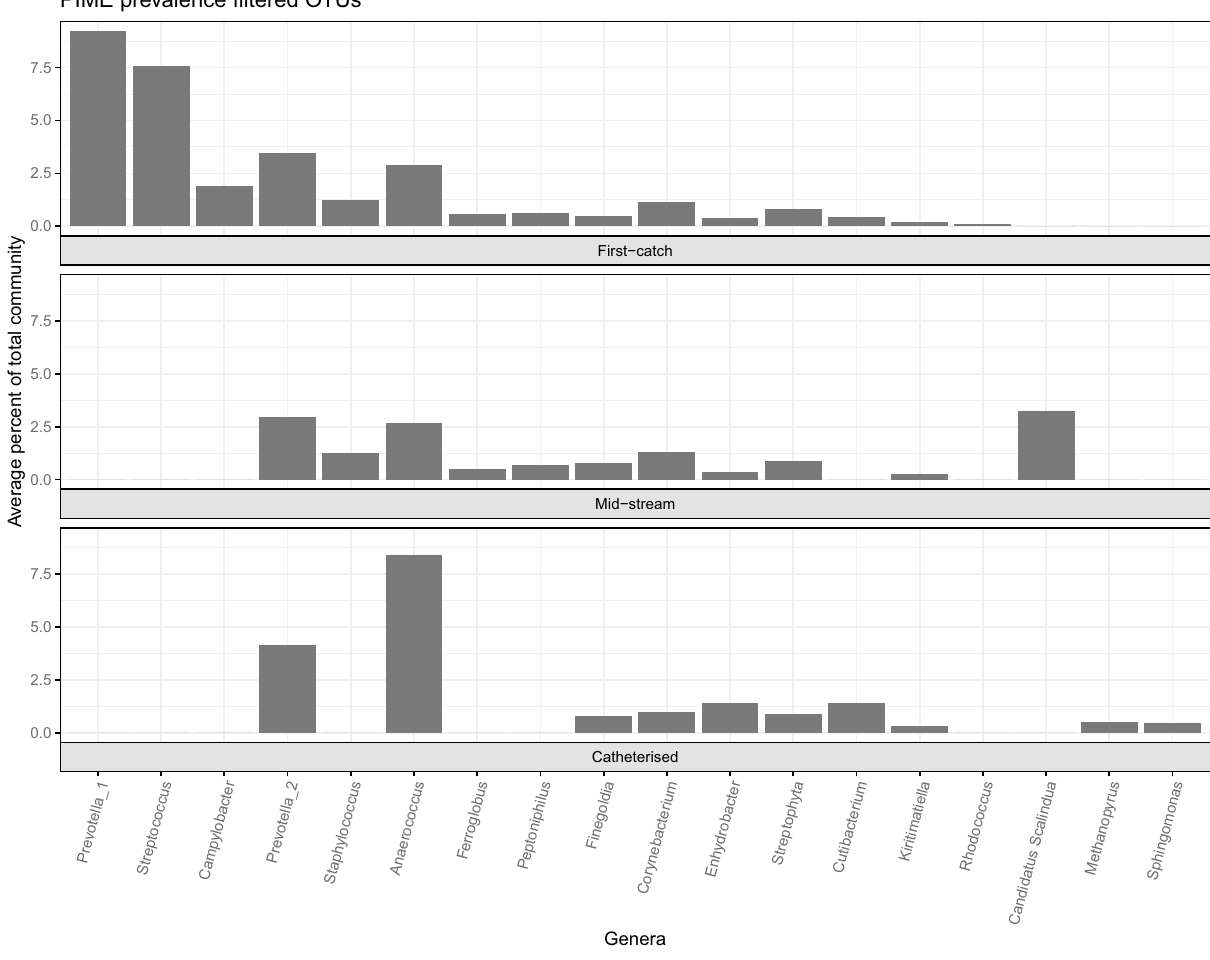
Figure 4. Relative abundance of 18 meaningful OTUs selected by PIME to discriminate among different urine sampling approaches. See also Supplementary Tables S3 and S4. Note: Prevotella_1 and Prevotella_2 correspond to CL0001 and CL0008, respectively, in the Supplementary Table